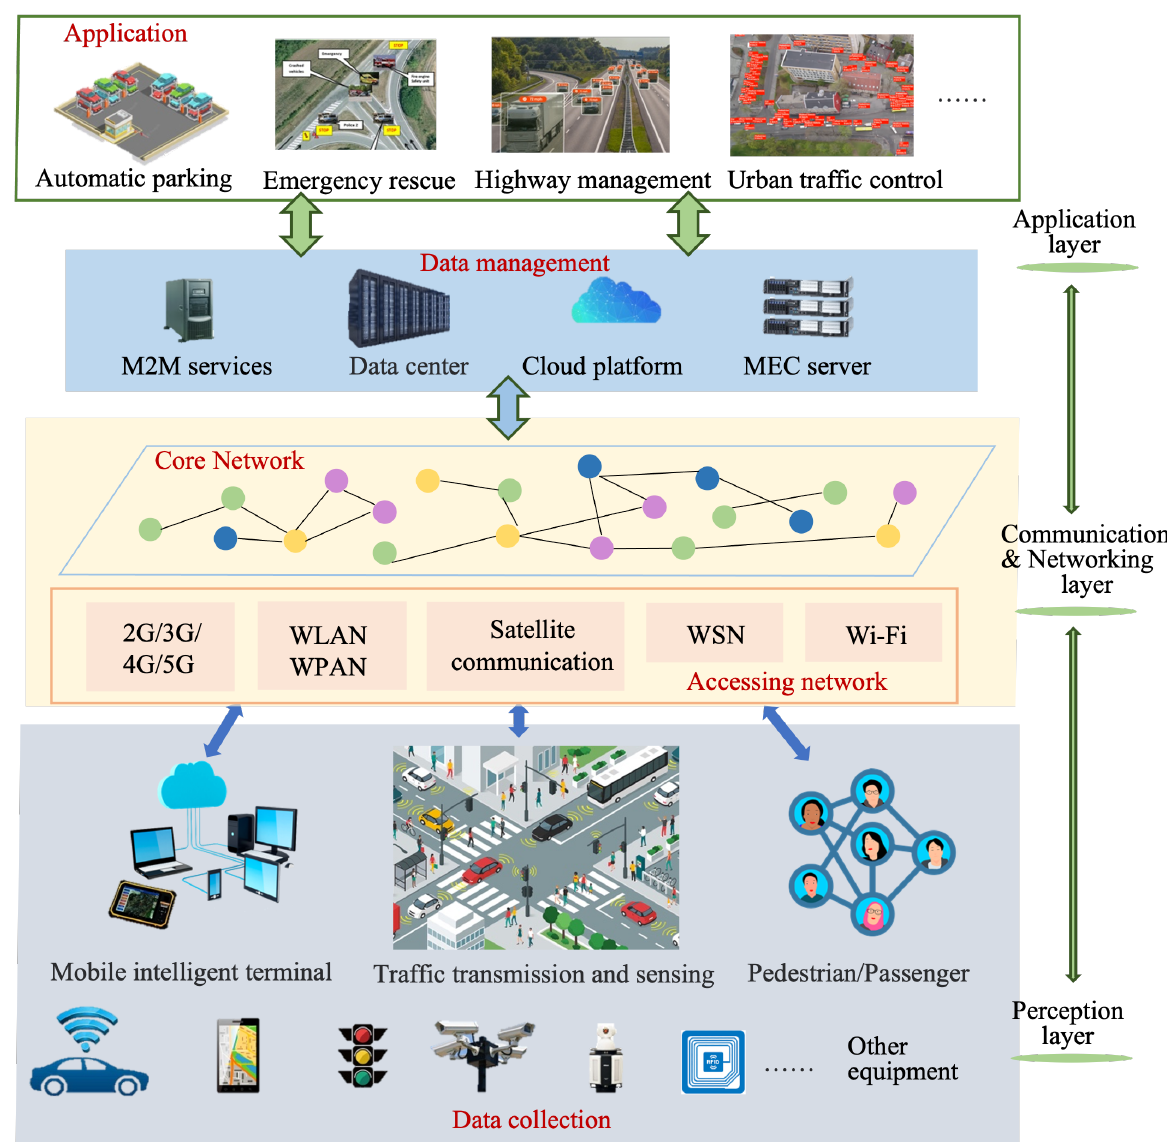
Figure 3. Three-layer Structure of Internet of